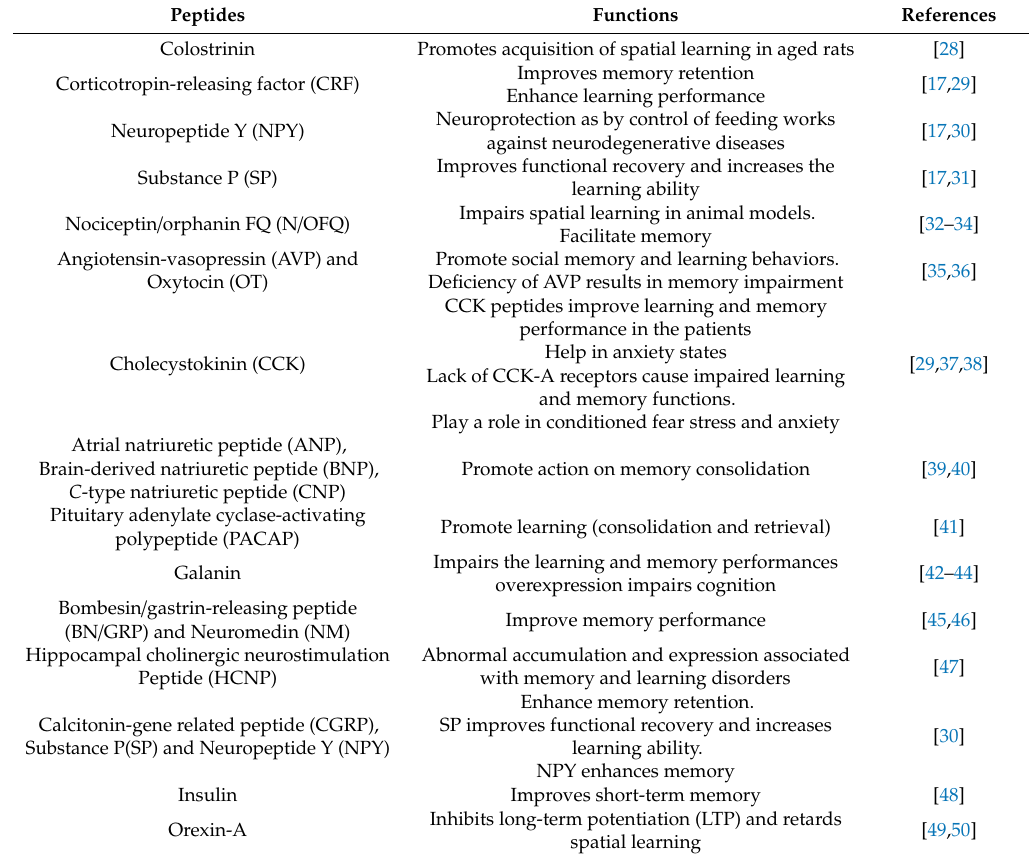
Table 1. Opioid-like peptides and their